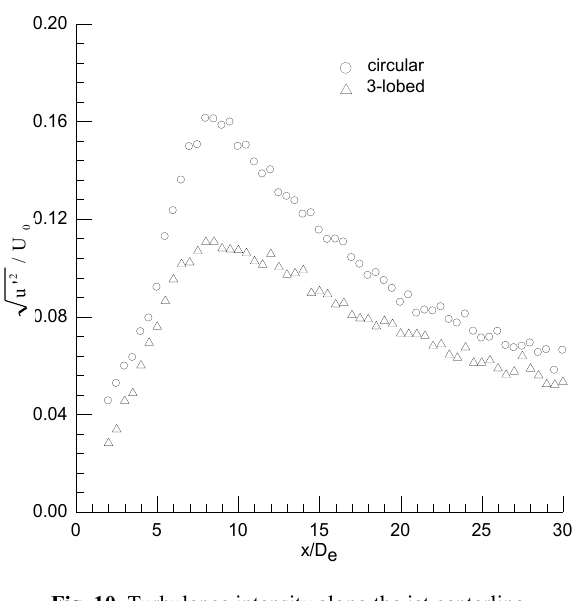
Fig. 10. Turbulence intensity along the jet centerline